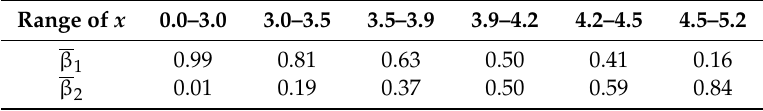
Table 1. Mean values of β 1 and β 2 for the six groups of x = log(T T ) within